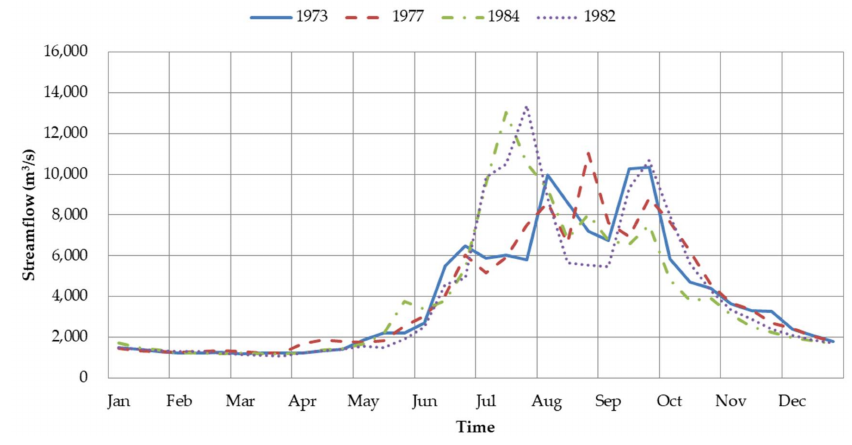
Figure 11. Streamflow of Pingshan station in dry years.